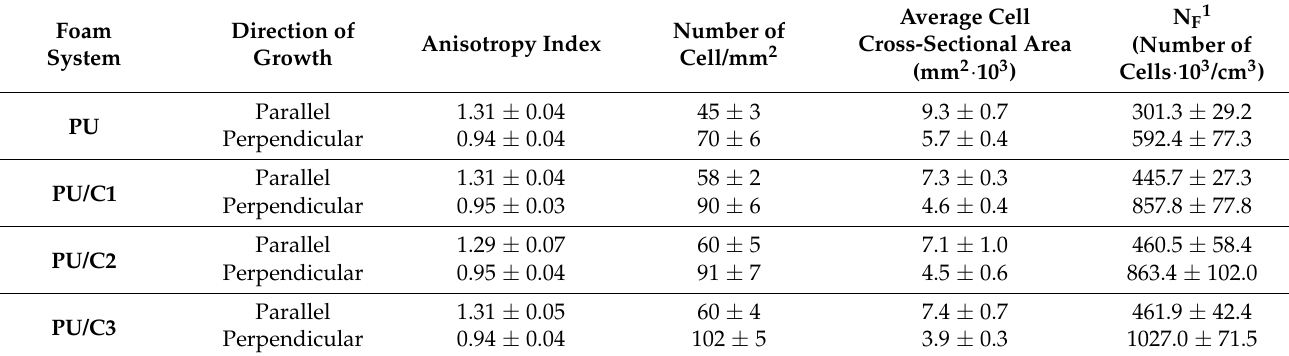
Figure 7. SEM images of PU, PU/C1, PU/C2, and PU/C3; magnification: × 40.